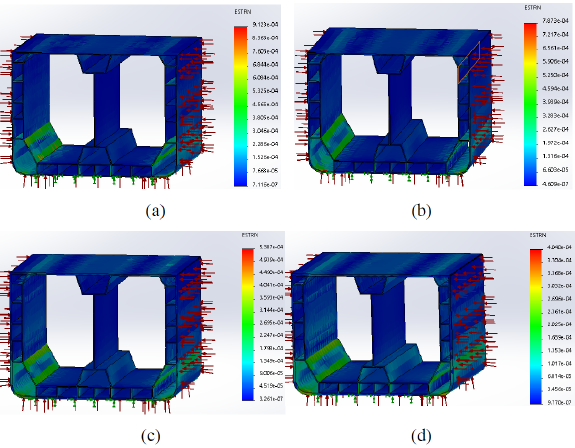
Figure 11: Strain contour plots at various plate thicknesses: (a) 100 mm, (b) 150 mm, (c) 200 mm, and (d) 250 mm.